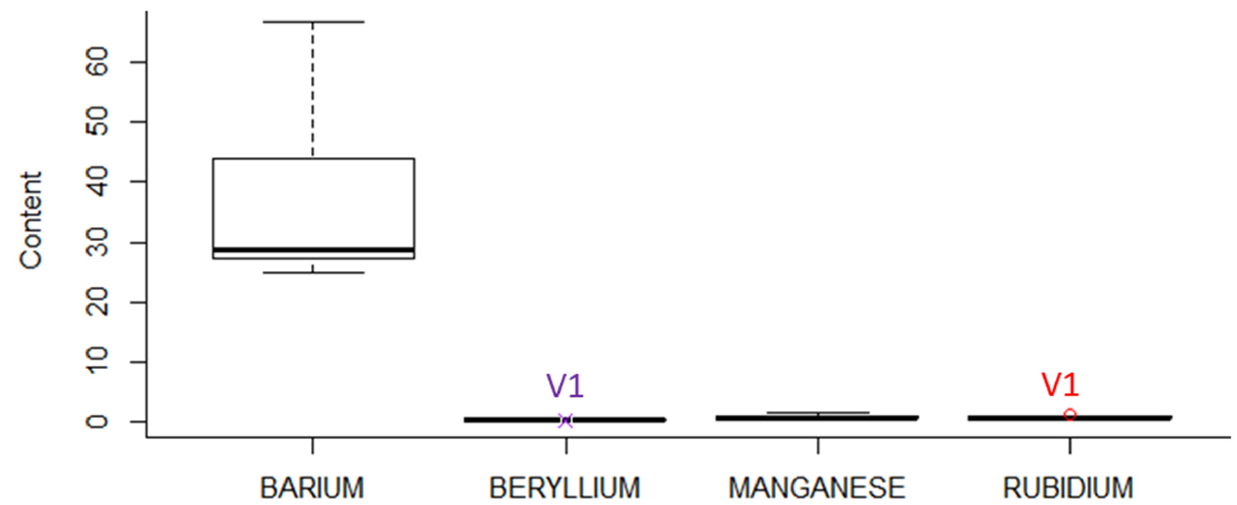
Figure 10. Boxplot of the most representative mineral elements present in wine, with a maximum (circle) and a minimum (cross) outlier. Beside the outlier symbol is the vineyard label.